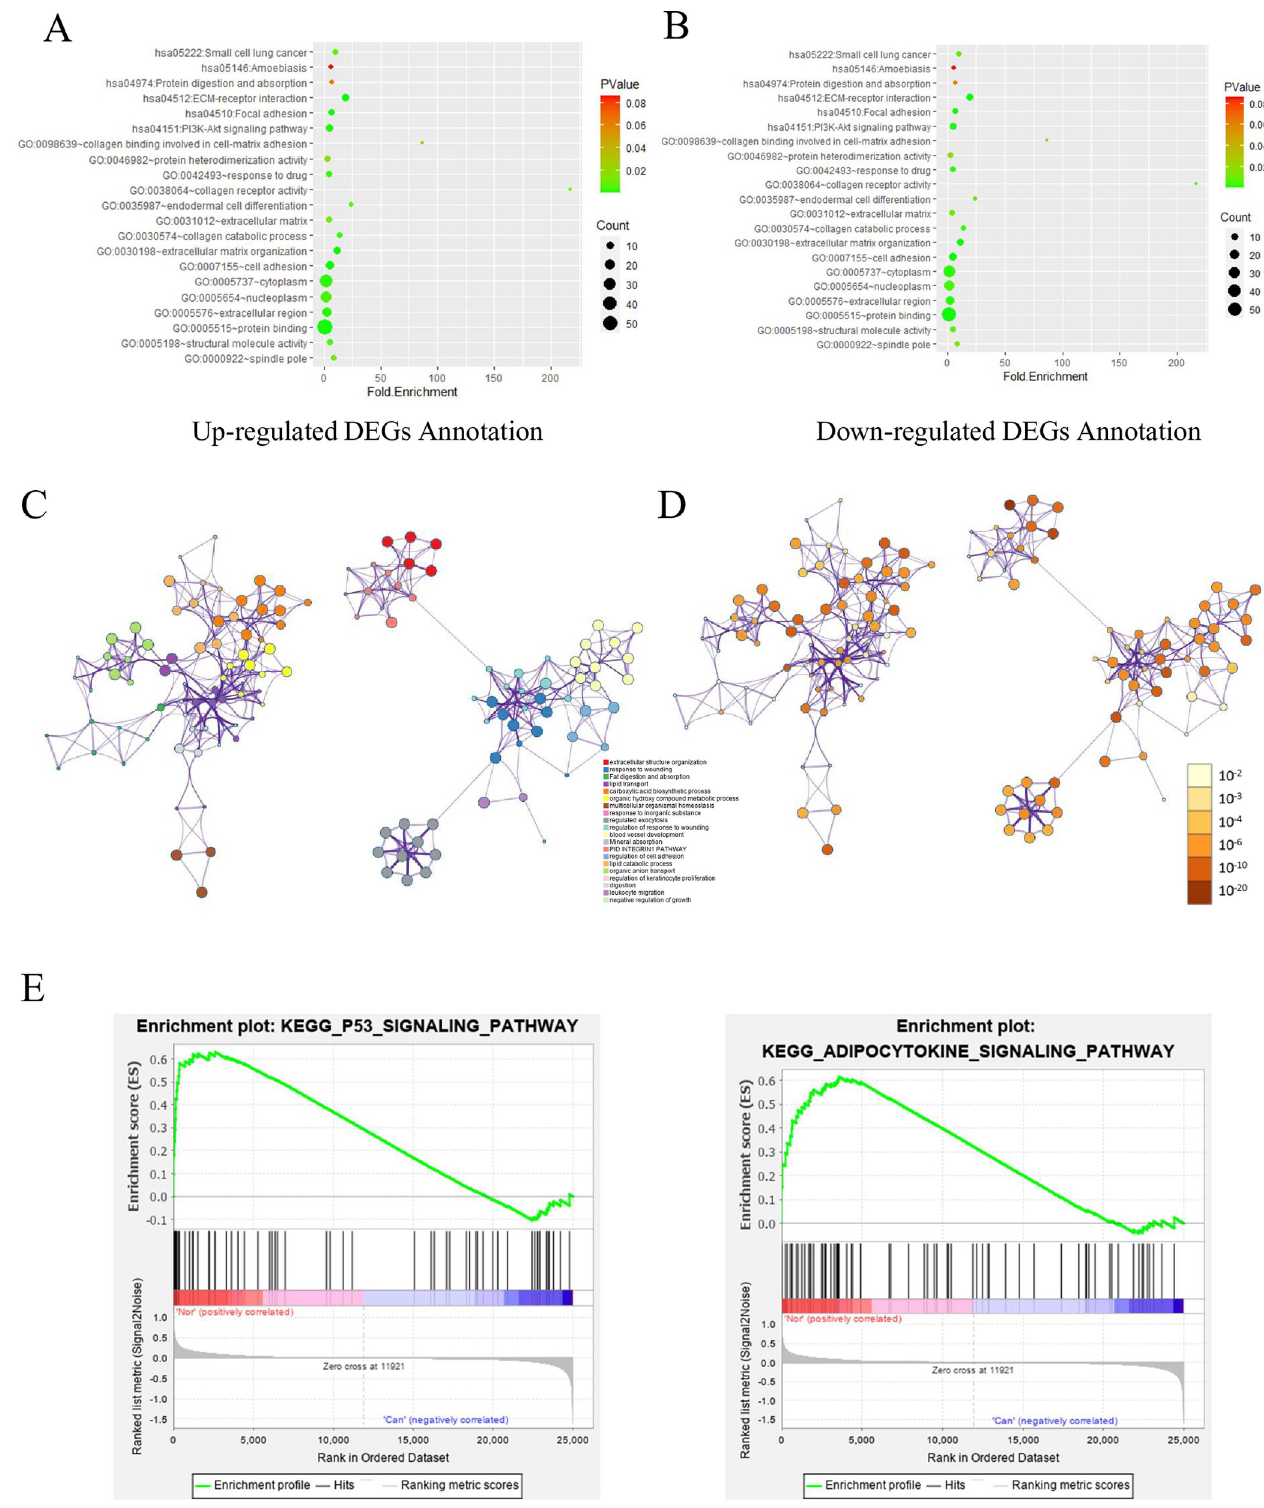
Fig 2. Functional and Pathway Enrichment Analysis (A) Functional annotation and enrichment of up-regulated DEGs. (B) Functional annotation and enrichment of down-regulated genes. (C) colored by cluster ID, where nodes that share the same cluster ID are typically close to each other in DEGs. (D) colored by p-value, where terms containing more genes tend to have a more significant P-value in DEGs. (E) GSEA analysis results.